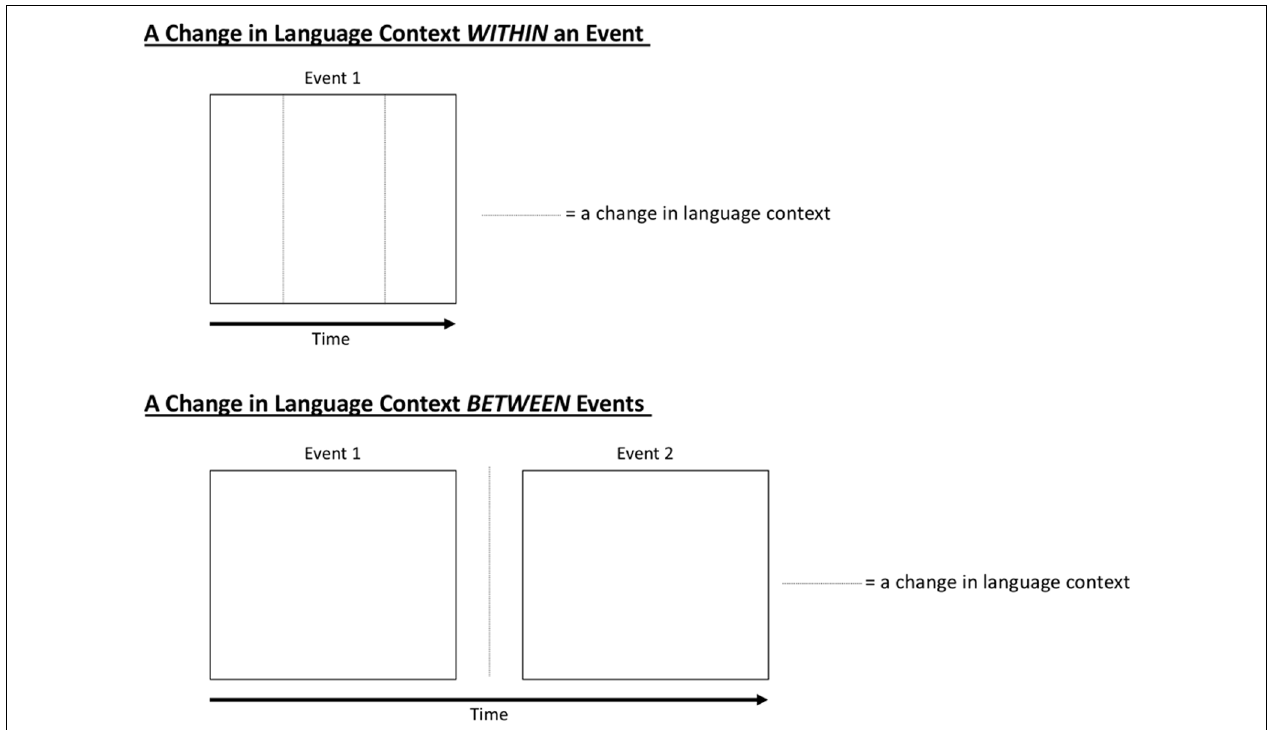
FIGURE 1 | How a change in language context could affect event segmentation. This image illustrates scenarios in which a change in language context could facilitate the parsing of an experience into events and subevents. The top panel (“A Change in Language Context WITHIN an Event”) depicts a situation in which there are two changes in language context during an event (e.g., from English to Spanish and then from Spanish to English), thereby creating three subevents (i.e., a beginning, middle, and end) within the larger event. The bottom panel (“A Change in Language Context BETWEEN Events”) depicts a situation in which there is a change in language context in between two larger events, such that one language context was present during Event 1 and a different language context was present during Event 2 (e.g., English in Event 1 and Spanish in Event 2).